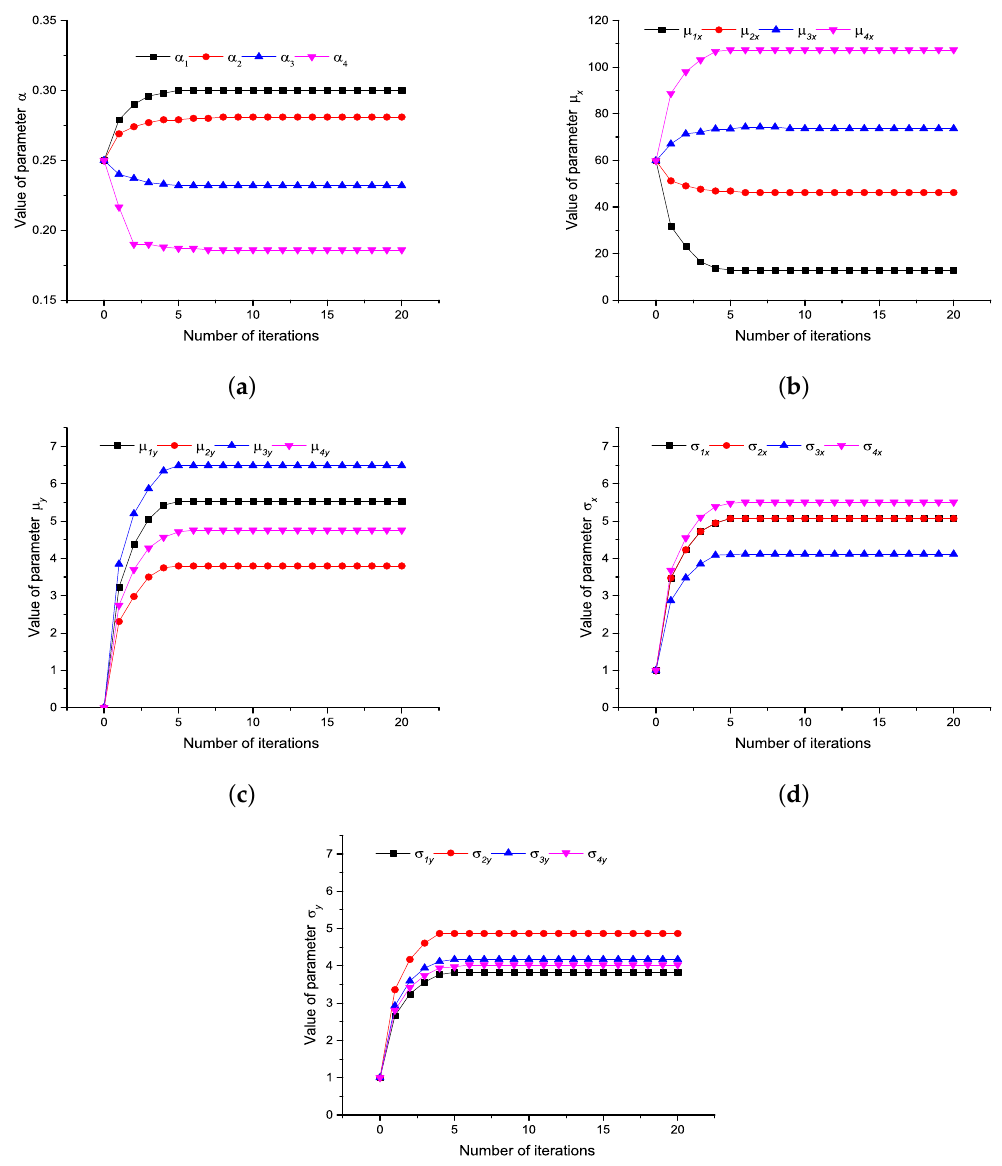
Figure 12. Parameter convergence process of Gauss mixed model ( a ) α convergence process; ( b ) µ x convergence process; ( c ) µ y convergence process; ( d ) Σ x convergence process; ( e ) Σ y convergence